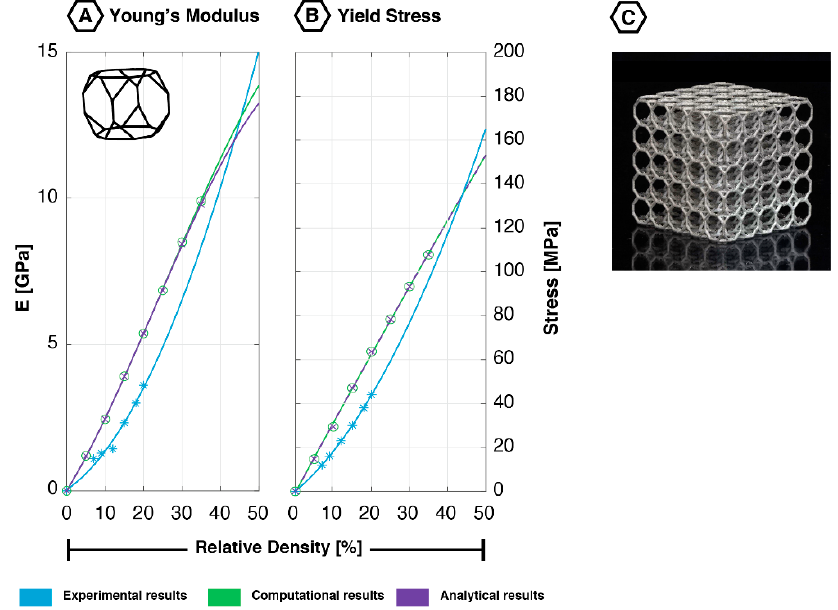
Figure 3. Mechanical properties of the truncated cube unit cell based on experimental, computational, and analytical studies: ( A ) Young’s modulus [18,19]; ( B ) yield stress [18,19]; ( C ) additively manufactured truncated cubic lattice (5 × 5 × 5 unit cells).